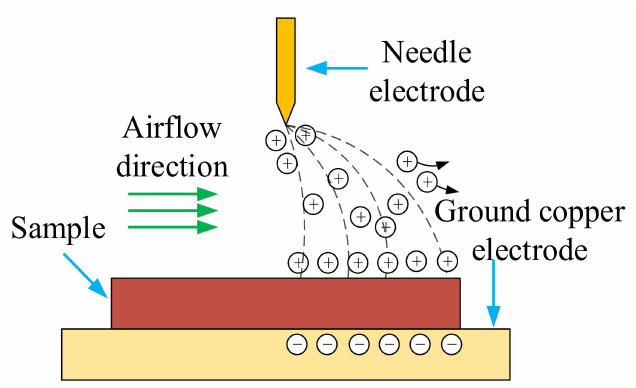
Figure 18. Charge movement characteristics of insulating media surface in an airflow